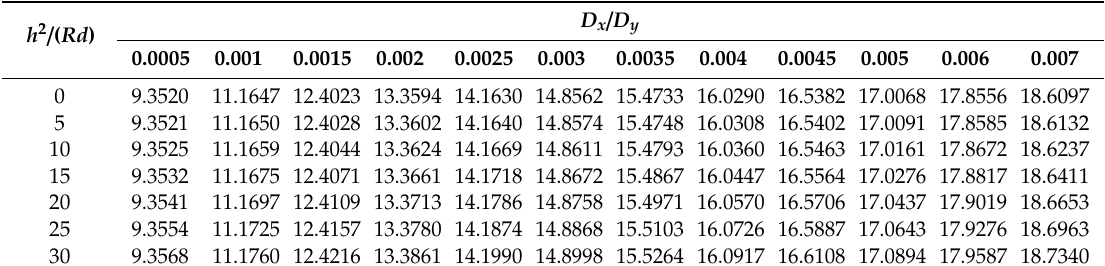
Table 6. Global shear buckling coefficient k g , fs for various values of h 2 /( Rd ) and D x / D y when l/h = 5, γ = 0.4 and β = 1.8 α for the two edges constrained by flanges fixed and the other two edges simply supported.